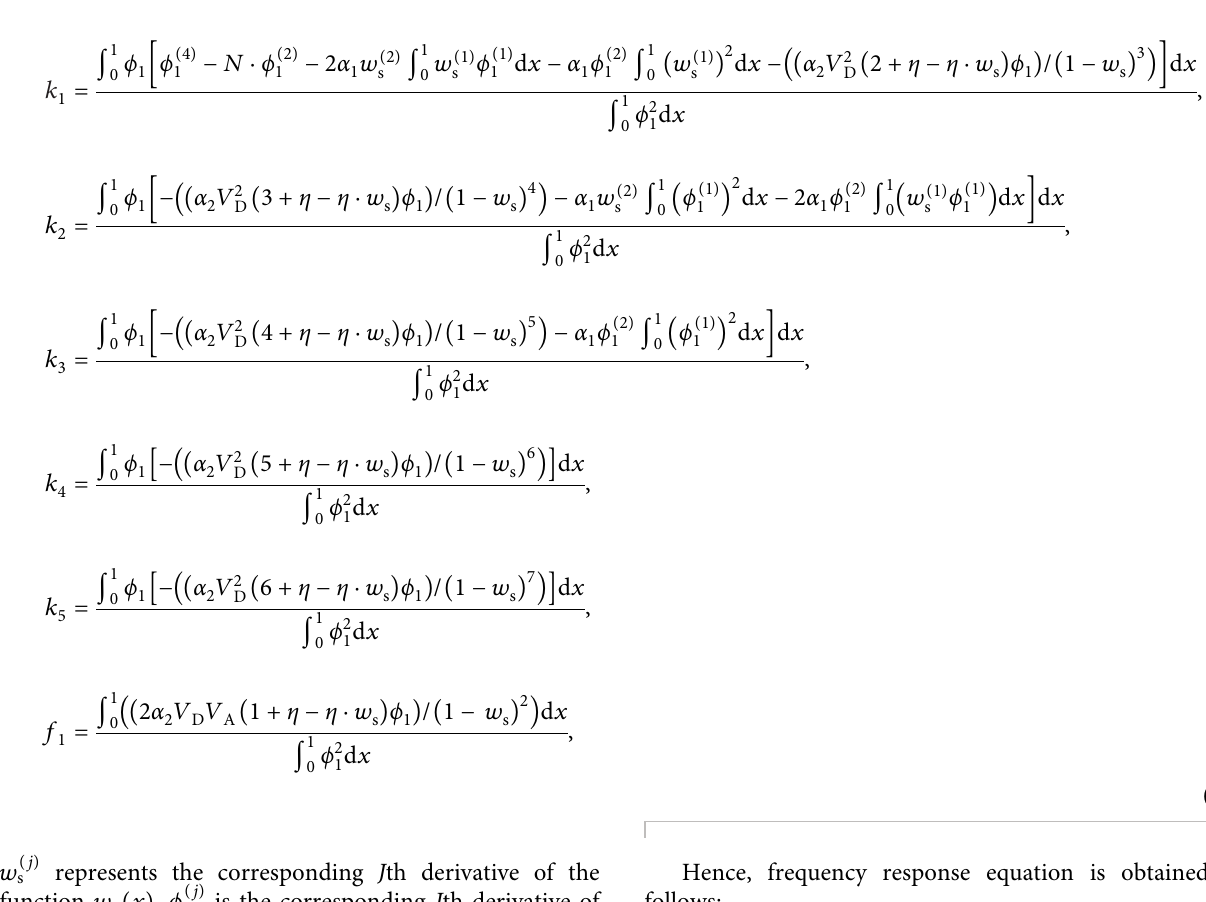
Figure 5: The effect of rotational stiffness on first-order frequency natural frequency. (a) Relationship between natural frequency and DC voltage under different rotational stiffness. (b) Variation trend of the natural frequency with rotational